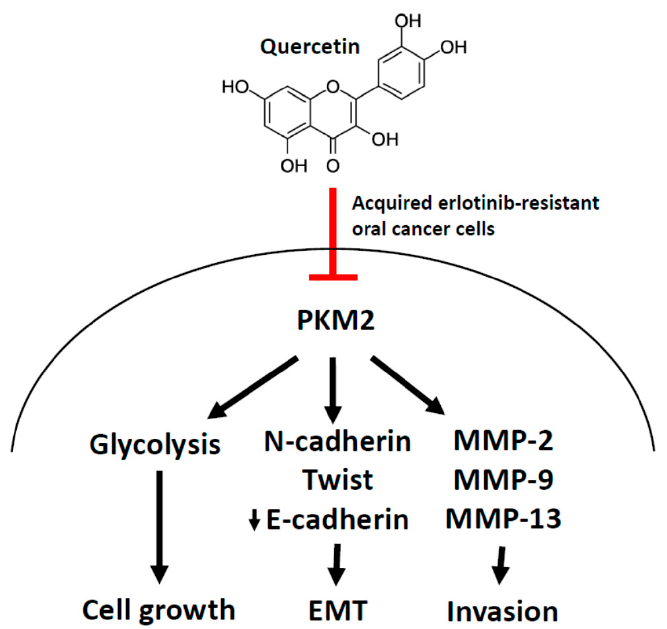
Figure 8. A schematic model depicting the role of quercetin and PKM2 in the regulation of erlotinib- resistant oral cancer cells. PKM2 was up-regulated in oral cancer cells resistant to erlotinib, which was highly associated with elevated glucose utilization, growth rate, EMT, and invasive progression of the erlotinib-resistant cells. Quercetin at 5 µ M potently hindered these acquired aggressiveness features in resistant cells by suppressing the PKM2